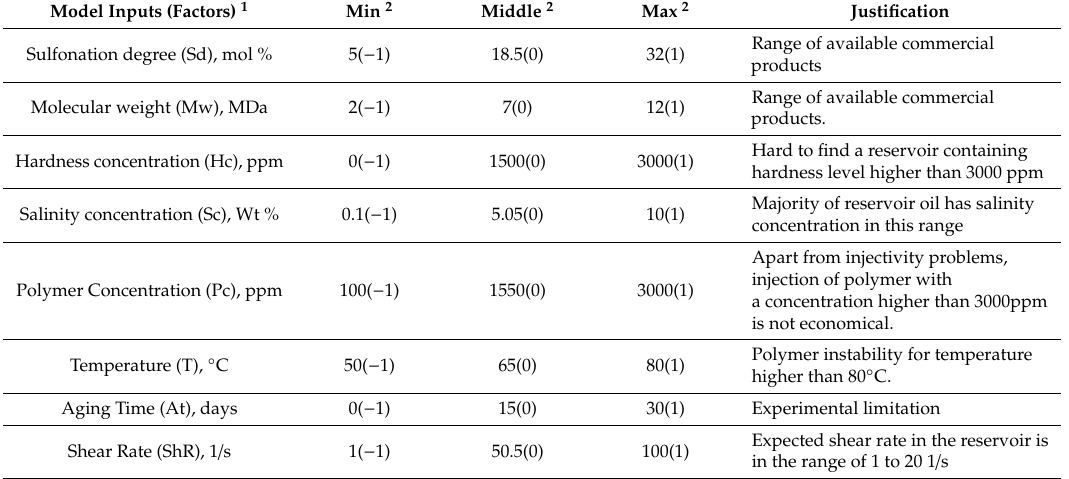
Table 1. Investigation range of model input